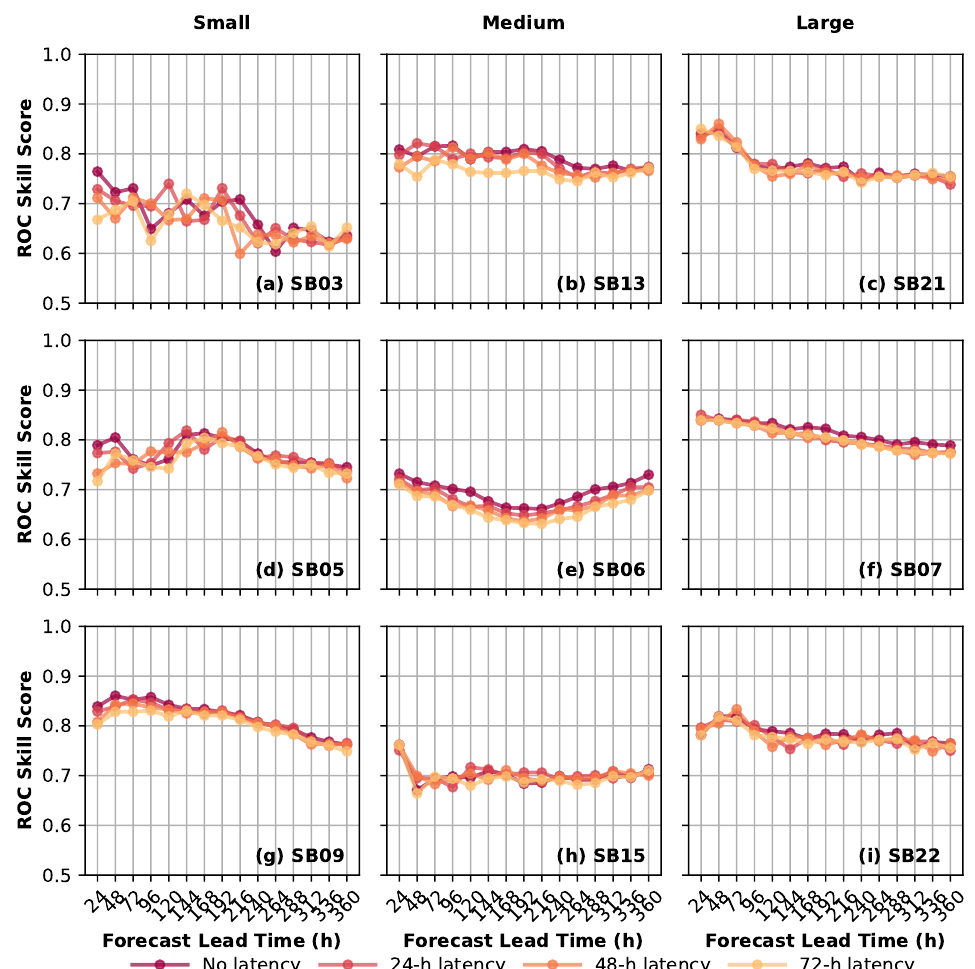
Figure 7. ROC skill score probabilistic streamflow forecast for the ECMWF ensemble model for a 3 d update and different latencies (0 h, 24 h, 48 h, and 72 h latencies) and drainage areas: small sub-basins (left column), medium sub-basins (center column), and larger sub-basins (right column), for streamflow with a probability level of